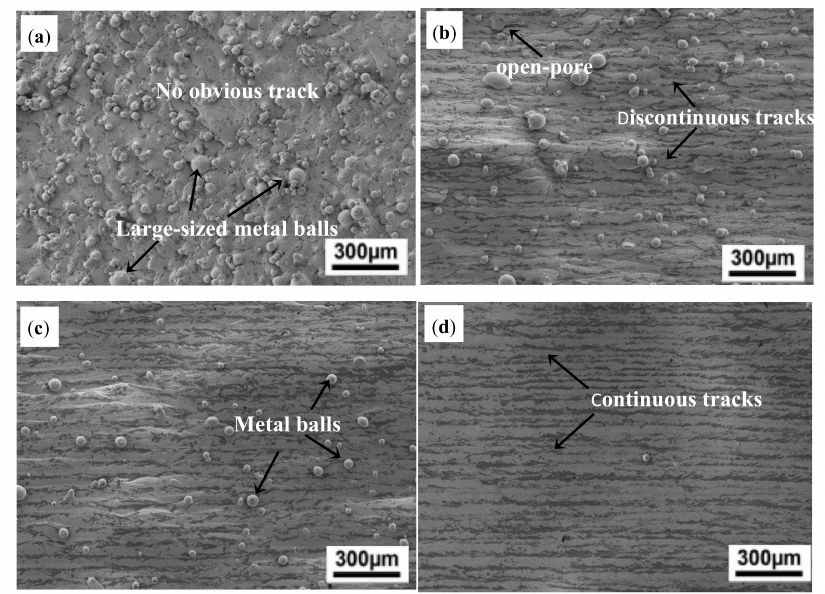
Figure 3. SEM images showing the typical upper surface morphologies of the as-built Inconel 718 specimens at various laser parameters: ( a ) E = 103 J/mm 3 ; ( b ) E = 143 J/mm 3 ; ( c ) E = 171 J/mm 3 ; ( d ) E = 190 J/mm 3